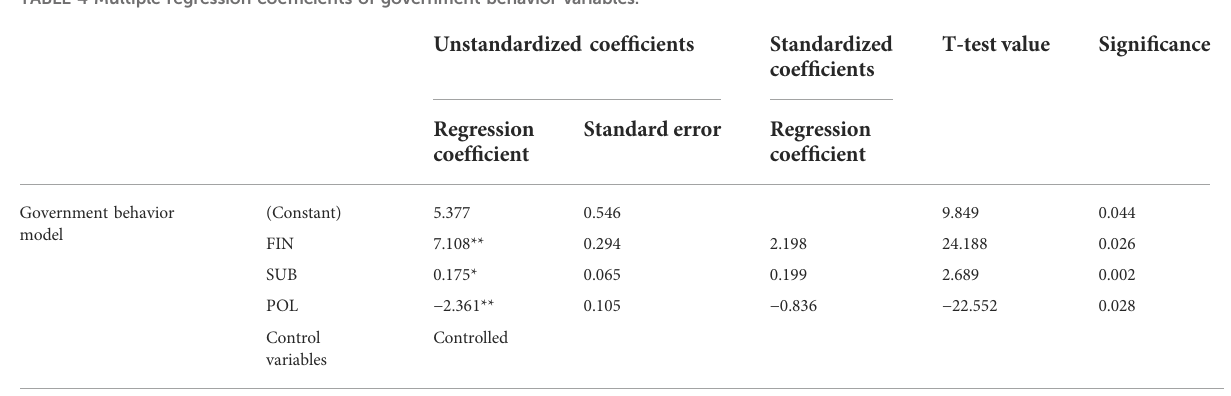
TABLE 4 Multiple regression coef fi cients of government behavior variables.